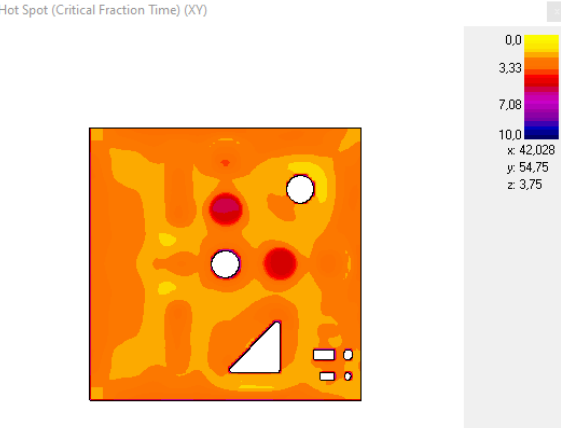
J. Manuf. Mater. Process. 2022 , 6 , x FOR PEER REVIEW Figure 3. Hot spot (based on CFS time) cut plane. Figure 3. Hot spot (based on CFS time) cut plane.